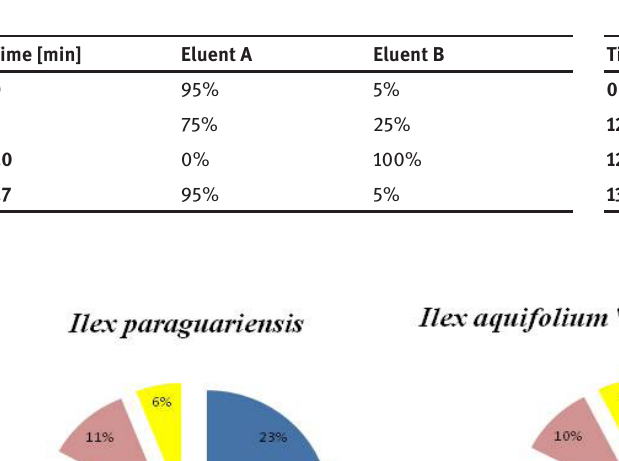
Table 1 : Gradient program used in HPLC separations. Table 2 : Gradient program used in LC MS separations.